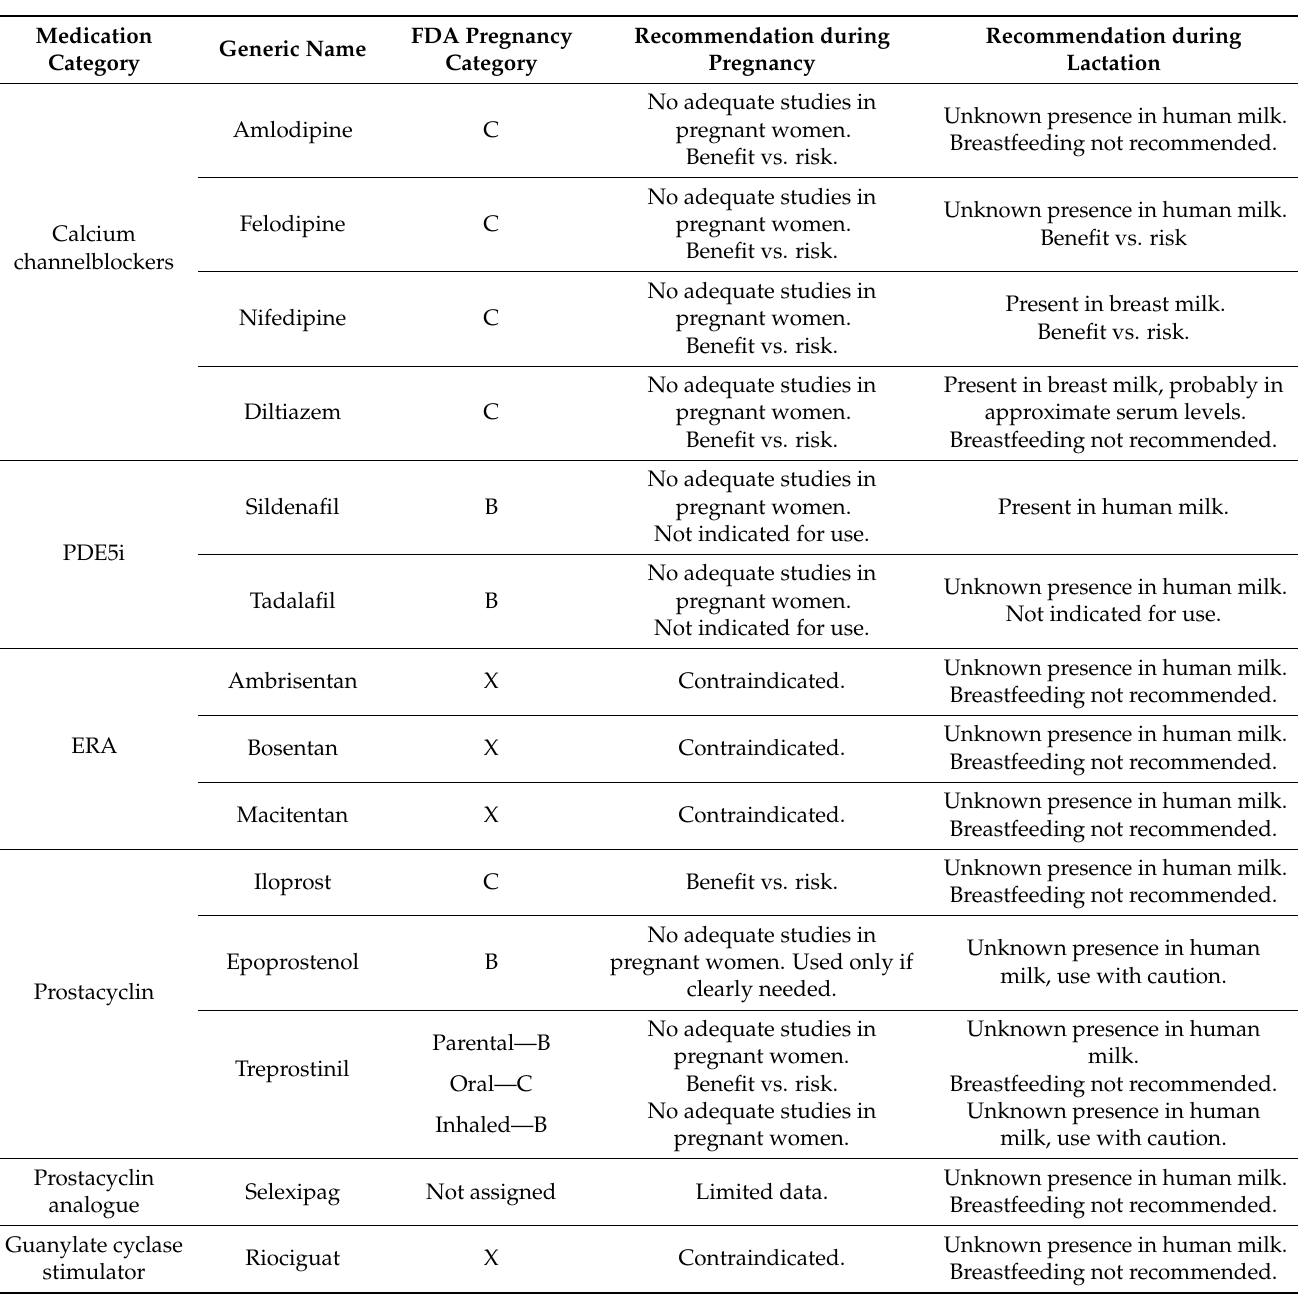
Table 1. Summary of FDA recommendations for the use of conventional therapy for pulmonary arterial hypertension during pregnancy and